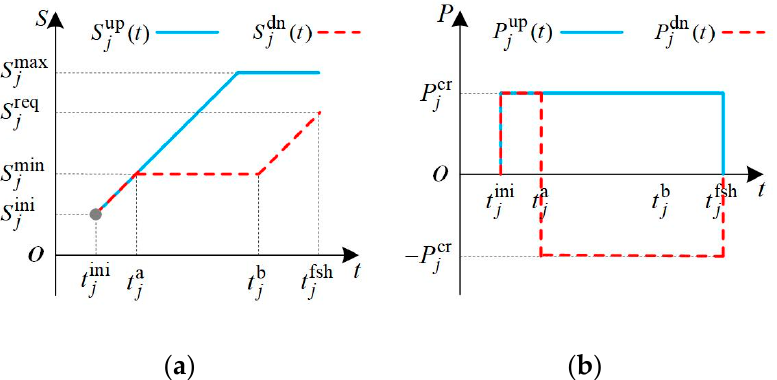
Figure 3. Regulation capacity of an EV with regulation mode 3: ( a ) SOC upper and lower boundaries; ( b ) power upper and lower boundaries.